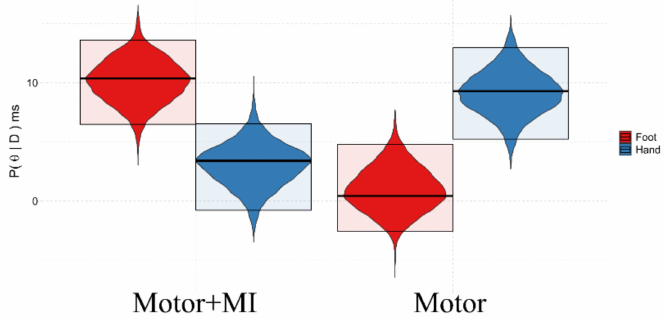
Figure 8. Graphical representation of the marginal posterior distributions (P( θ |D)) of the Back- ground:Group interaction. Description as in Figure 4. H1 = Pr(x > 0) > 83.5%, meaning that the BSE is greater than zero, indicating a preserved body representation. Motor + MI = Motor Treatment and Motor Imagery group. Motor = Motor Treatment only group.